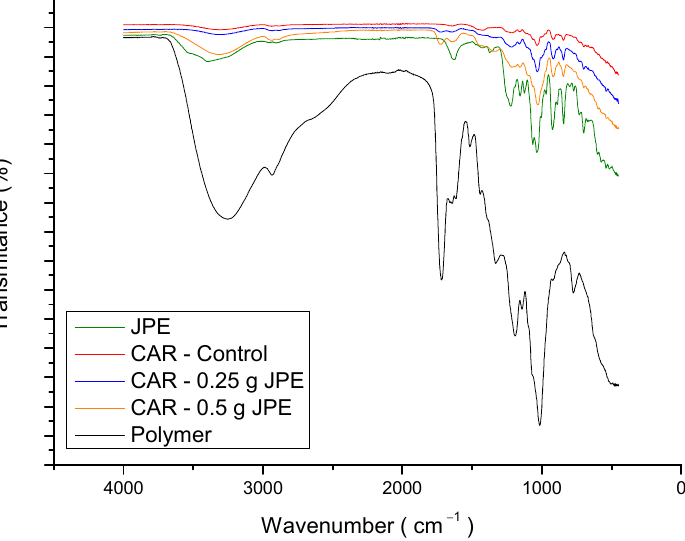
Figure 4. FTIR spectra of JPE, carrageenan powder, and biodegradable films, with and without JPE at different concentrations.